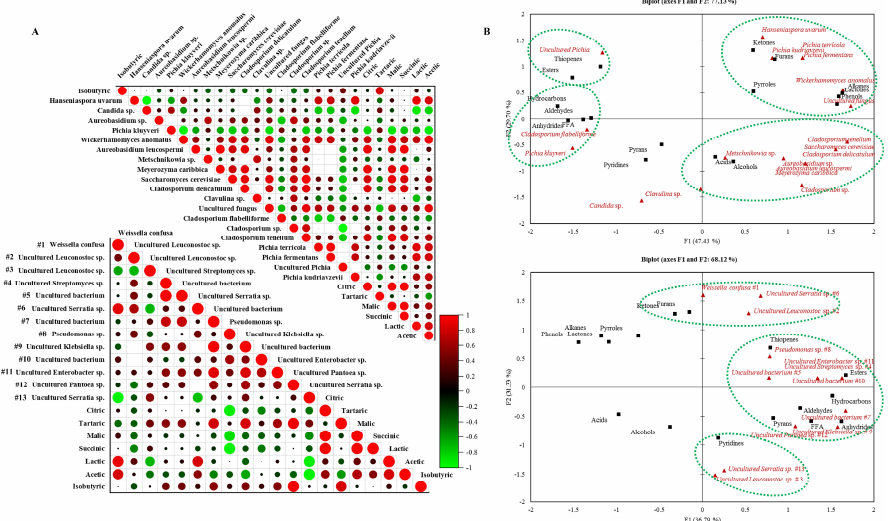
Figure 5 Figure 4. ( A ) Down-stream Pearson correlation matrix of bacteria and organic acids. Down-stream Pearson correlation matrix of fungi and organic acids. ( B ) Principal component analysis (PCA) of all the detected volatile groups, fungi, and